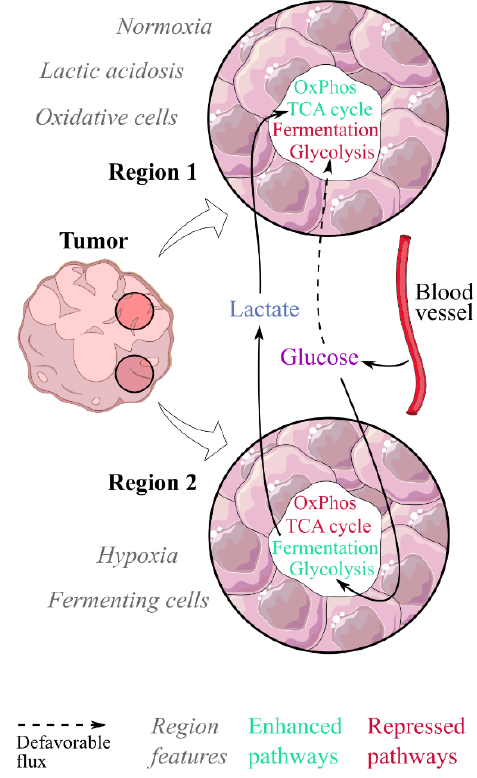
Figure 2. Lactic acidosis would contribute to a metabolic symbiosis between fermenting and oxida- tive cells within tumours. In this model, two populations coexist in tumours: fermenting cells in hypoxic regions, and oxidative cells in normoxic regions where lactic acidosis would exert its effect. Fermenting cells would consume the glucose spared by oxidative cells and generate the lactate fueling them, both being in a metabolic symbiosis. Lactic acidosis promotes the switch from a fermenting to an oxidative phenotype.